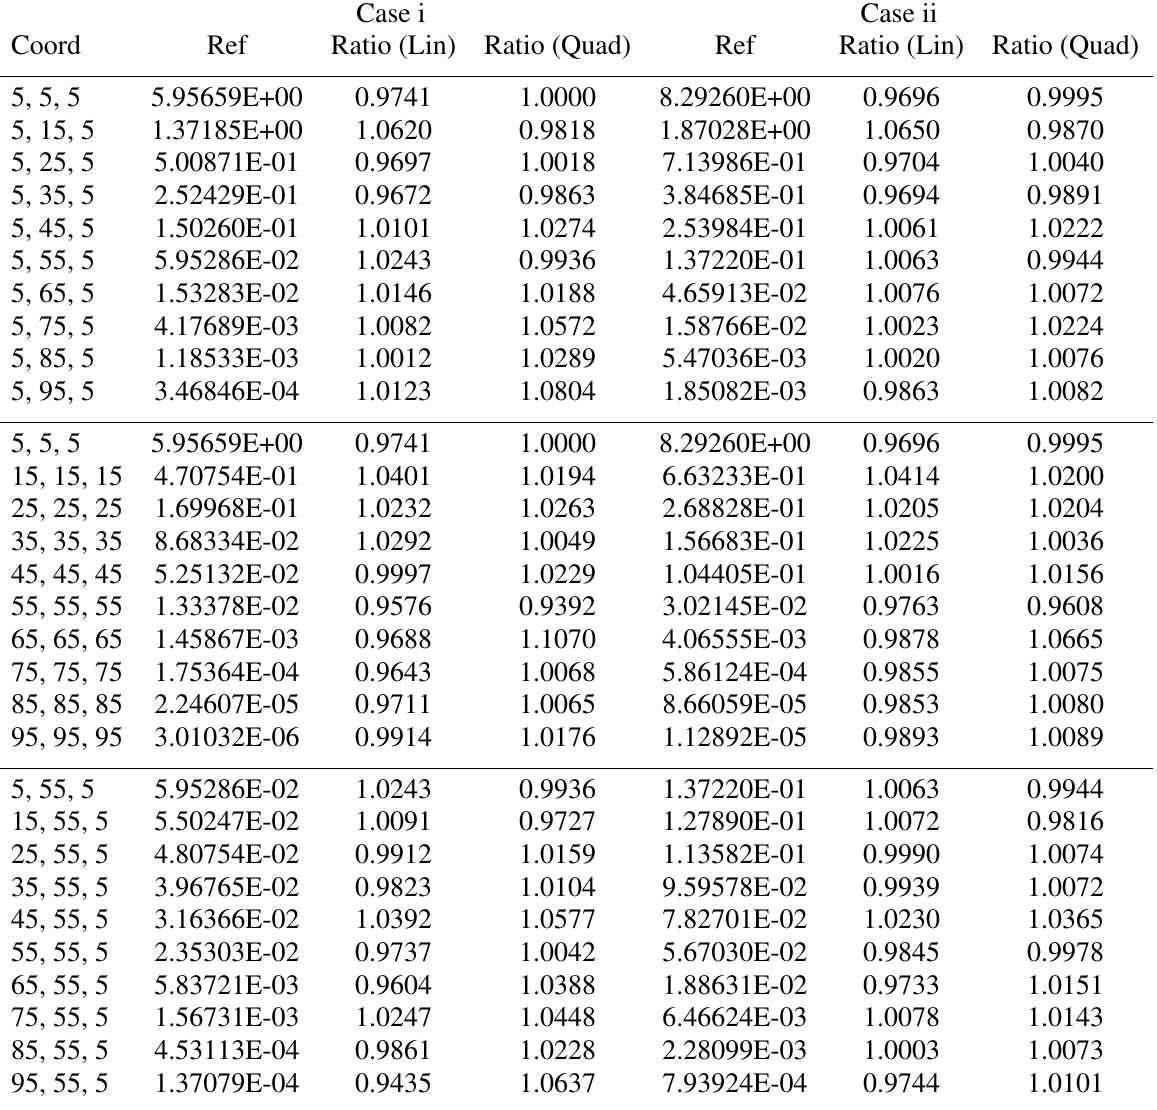
Table 2: Results for Kobayashi problem